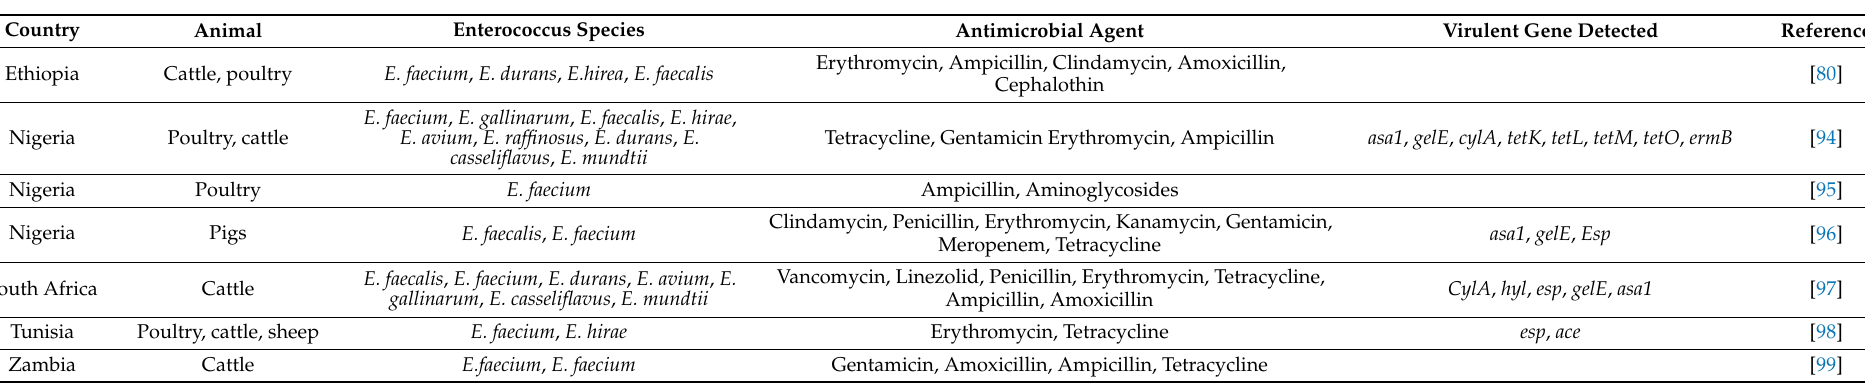
Table 3. Enterococcus virulent genes detected from different animals by antimicrobial agent and